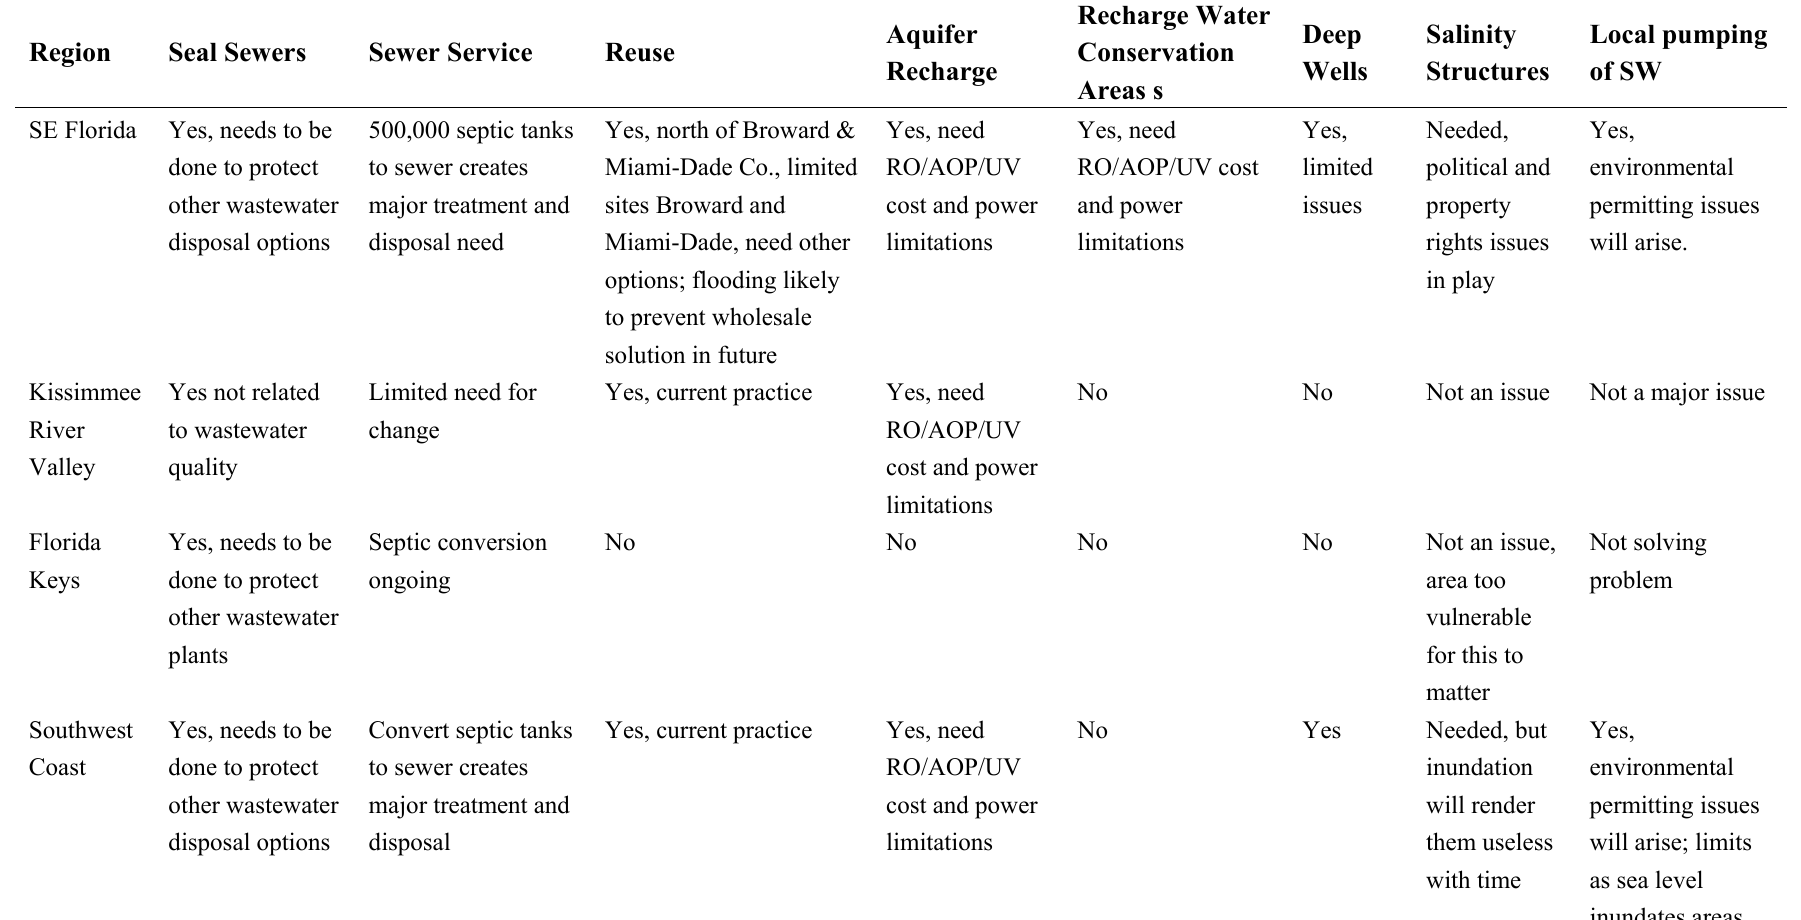
Table 4. Waste and stormwater supply